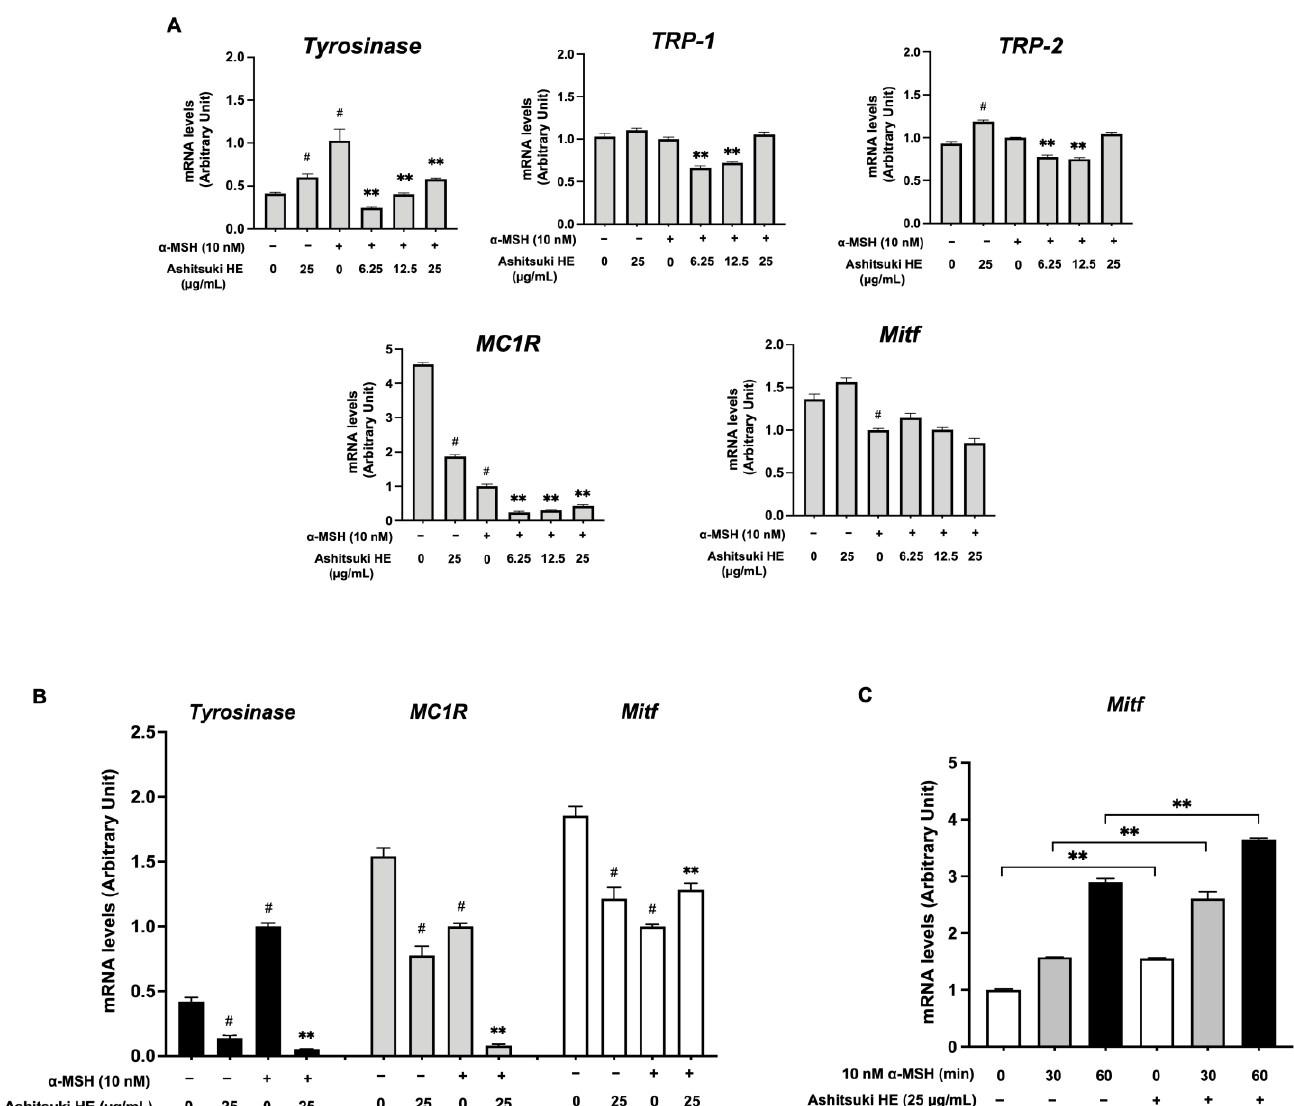
Figure 9. Effect of N. verrucosum ( ashitsuki ) hexane extract on melanogenic gene transcription. B16F1 melanoma cells were treated with N. verrucosum hexane extract and stimulated with 10 nM α -MSH for 72 h ( A ) and 6 h ( B ). ( C ) The cells were pre-treated with N. verrucosum hexane extract for 1 h; thereafter, α -MSH (10 nM) was added to the cells, which were then incubated for 30 or 60 min in the presence of α -MSH. Total RNA was extracted and cDNA was prepared. An equivalent amount of cDNA was amplified using primers specific for tyrosinase , TRP-1 , TRP-2 , Mitf , and MC1R . Results are represented as arbitrary unit of the α -MSH-alone-treated control group; the data are mean ± SEM of three separate experiments. # p < 0.05 versus the control group. ** p < 0.01 versus the α -MSH-alone-treated control group.